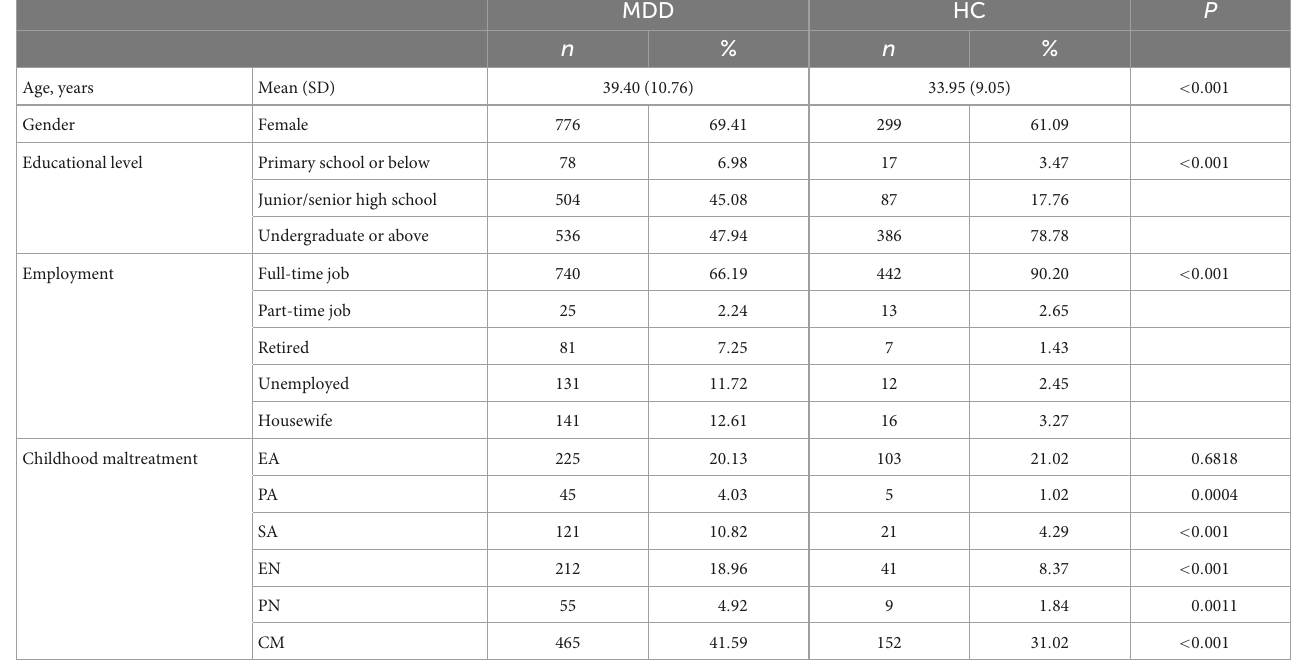
TABLE 1 Social-demographic information and prevalence of CM for MDD and HC